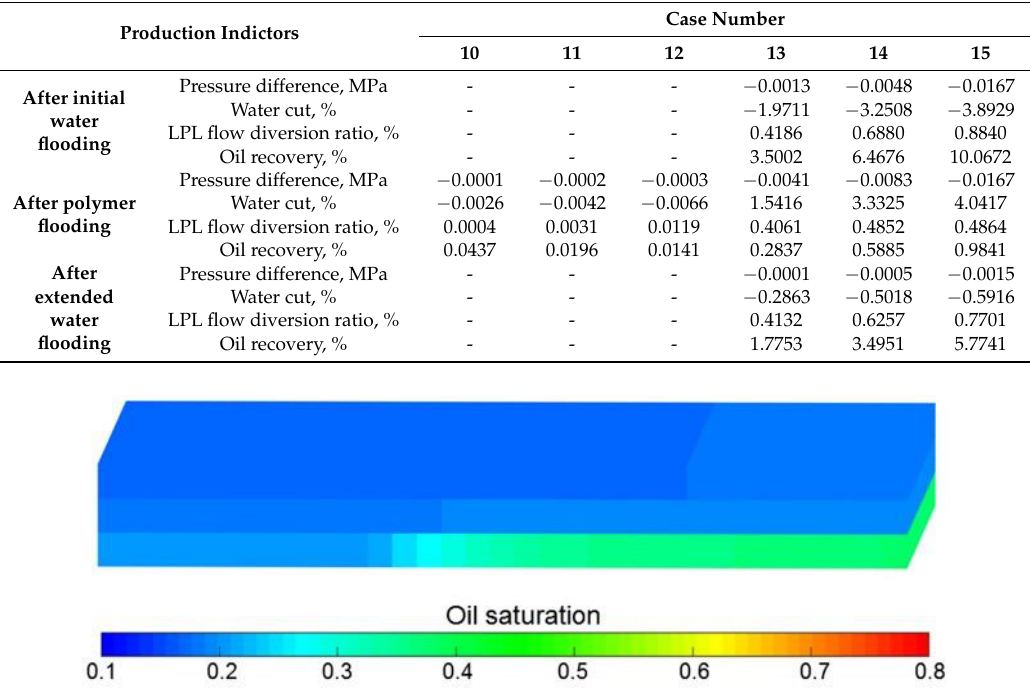
Table 10. Production indicator reductions of Cases 10 – 12 vs. Case 3, and those of Cases 13 – 15 vs. Case 6.